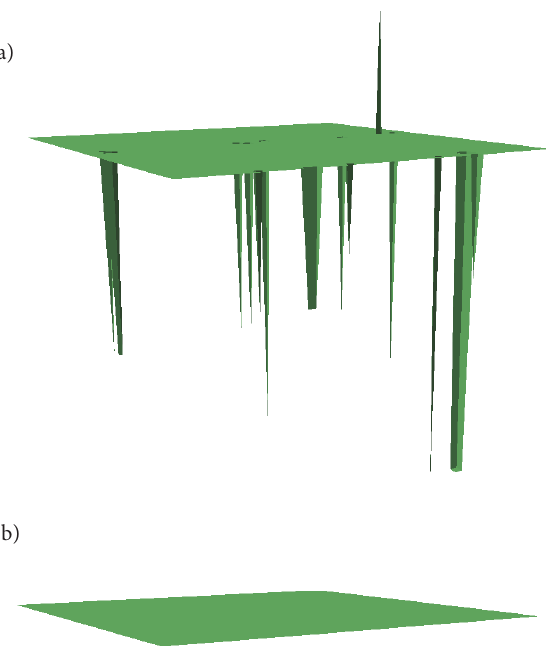
Fig. 2. The points cloud without gross errors: a – graphical representation of the points cloud; b – graphical representation of the created surface